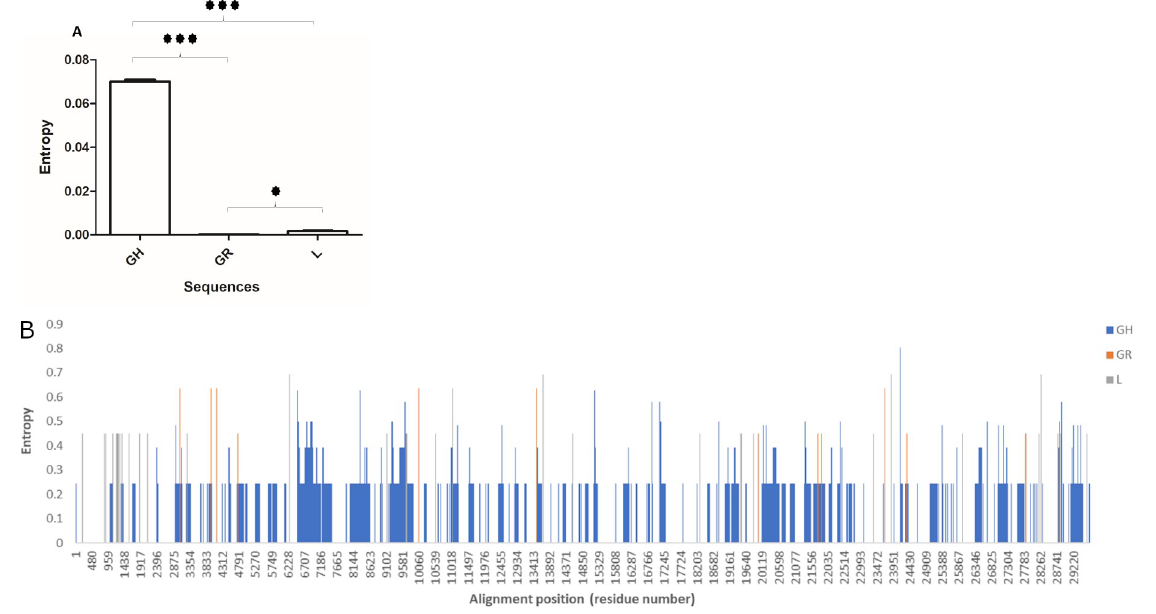
Fig 6. Genome-wide site-by-site entropy analysis for prevalent clades L, GR and GH. The figure shows A) Mean entropy and B) site-by-site entropy for GH, GR and L clade sequences A) The asterisk above the bars show statistically significant ( ��� = p < 0.001; � = p < 0.05) difference between the means. Error bars shown standard error of